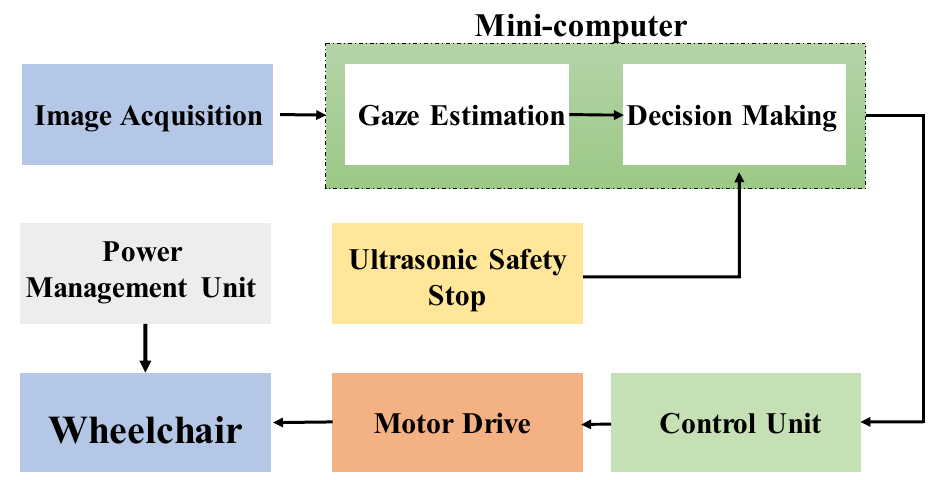
Figure 3. Eye Controlled Wheelchair block diagram.